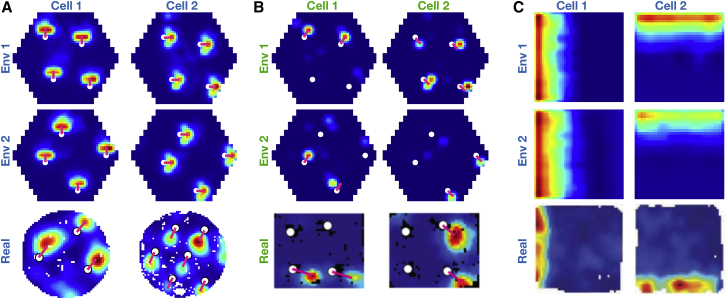
TEM Learned Representations Reflect Transition StatisticsWhen the agent’s transition statistics mimic different behaviors, TEM learns new representations (left to right: different cells; top to bottom: environments 1, 2, real data).(A) When biased to move toward objects (white dots) TEM learns structural cells with a vector relationship to the objects—object vector cells (Høydal et al., 2019). These cells generalize to all objects.(B) TEM hippocampal cells reflect this behavioral transition change with similar cells, though they do not generalize to all objects—landmark cells (Deshmukh and Knierim, 2013).(C) When biased toward boundaries, TEM learns border cell-like representations (Solstad et al., 2008).